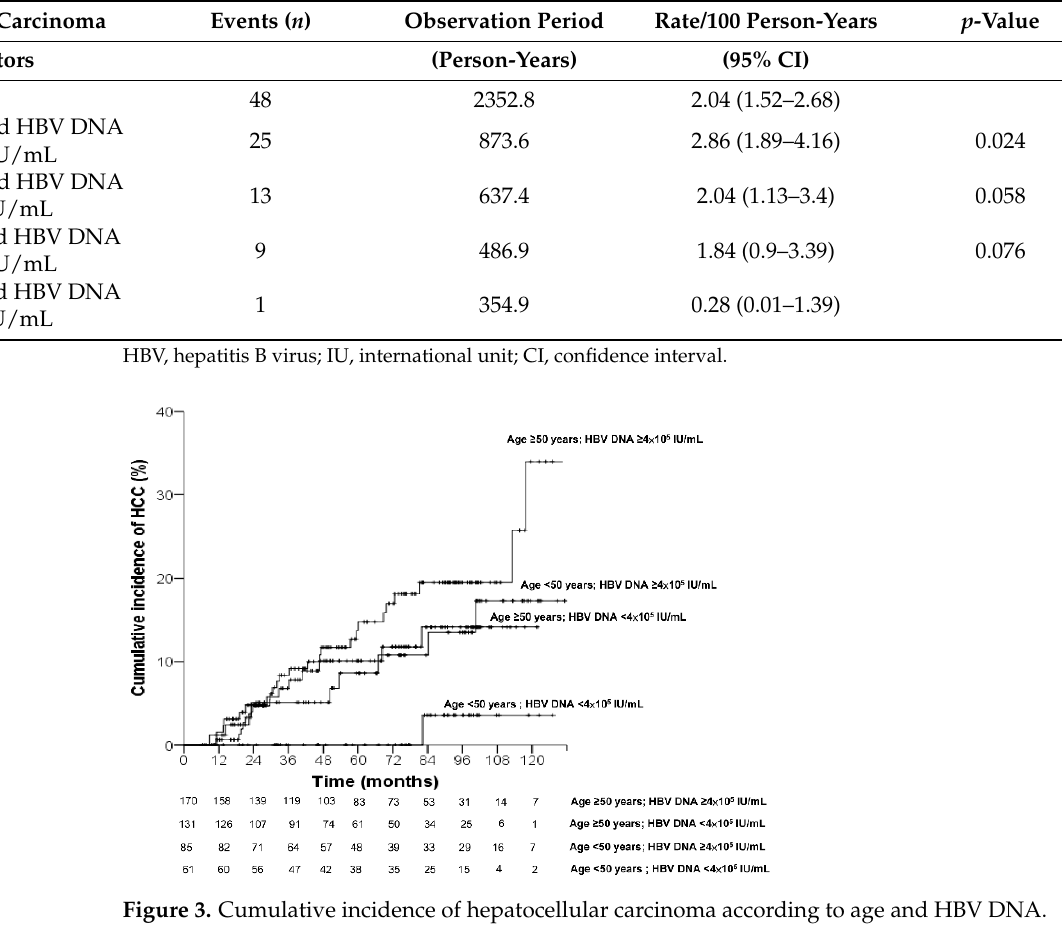
Table 4. Incidence rates of hepatocellular carcinoma stratified according age and HBV DNA.